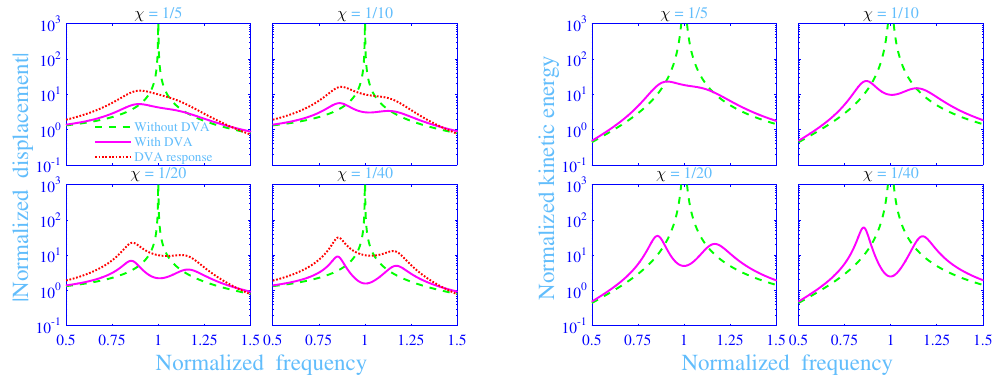
Figure 4. Absolute value of the normalized displacement and the normalized kinetic energy of the mass M versus the normalized frequency with and without the dynamic vibration absorber (DVA) together with the absolute value of the normalized displacement of the mass m versus the normalized frequency, at various mass ratios χ , with α = 0 and C =